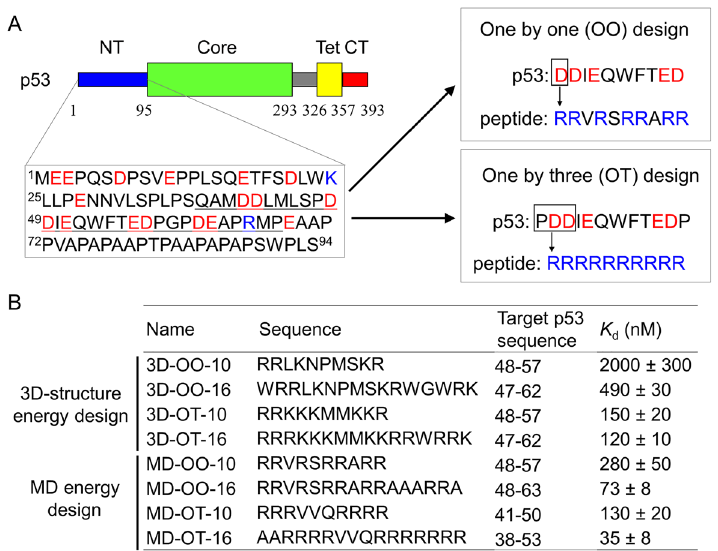
Figure 2. Peptide design scheme and binding properties of the designed peptides to p53 N-terminal IDR. ( A ) Schematic diagram of peptide design targeting p53 N-terminal IDR. NT, Core, Tet, and CT in the primary sequence of p53 represent the N-terminal, core, tetramerization, and C-terminal domains, respectively (top left), where thick and thin bands represent folded and disordered regions, respectively. The NT sequence (1–94) was used for the present peptide design (bottom right). Blue and red characters denote positive and negative charged residues, respectively. The peptide sequences with the highest binding property were designed based on the calculation of one-by-one (OO) or one-by-three (OT) contact energy for each residue of the p53 sequence (right). Ten-residue peptides designed with the MD-based energy are shown as examples. ( B ) Sequence, complimentary target residue number, and dissociation constant ( K d ) of designed peptides used in this study. The top and bottom four peptides were designed with the 3D structure-based and MD-based energies, respectively. For example, 3D-OO-10 and MD-OT-16 designate a 10-residue peptide designed with 3D structure-based OO contact energy and a 16-residue peptide designed with the MD-based OT contact energy, respectively. K d was determined by titrating peptides against the target p53 N-terminal peptide fragment underlined in ( A ). Errors represent the fitting errors of titration